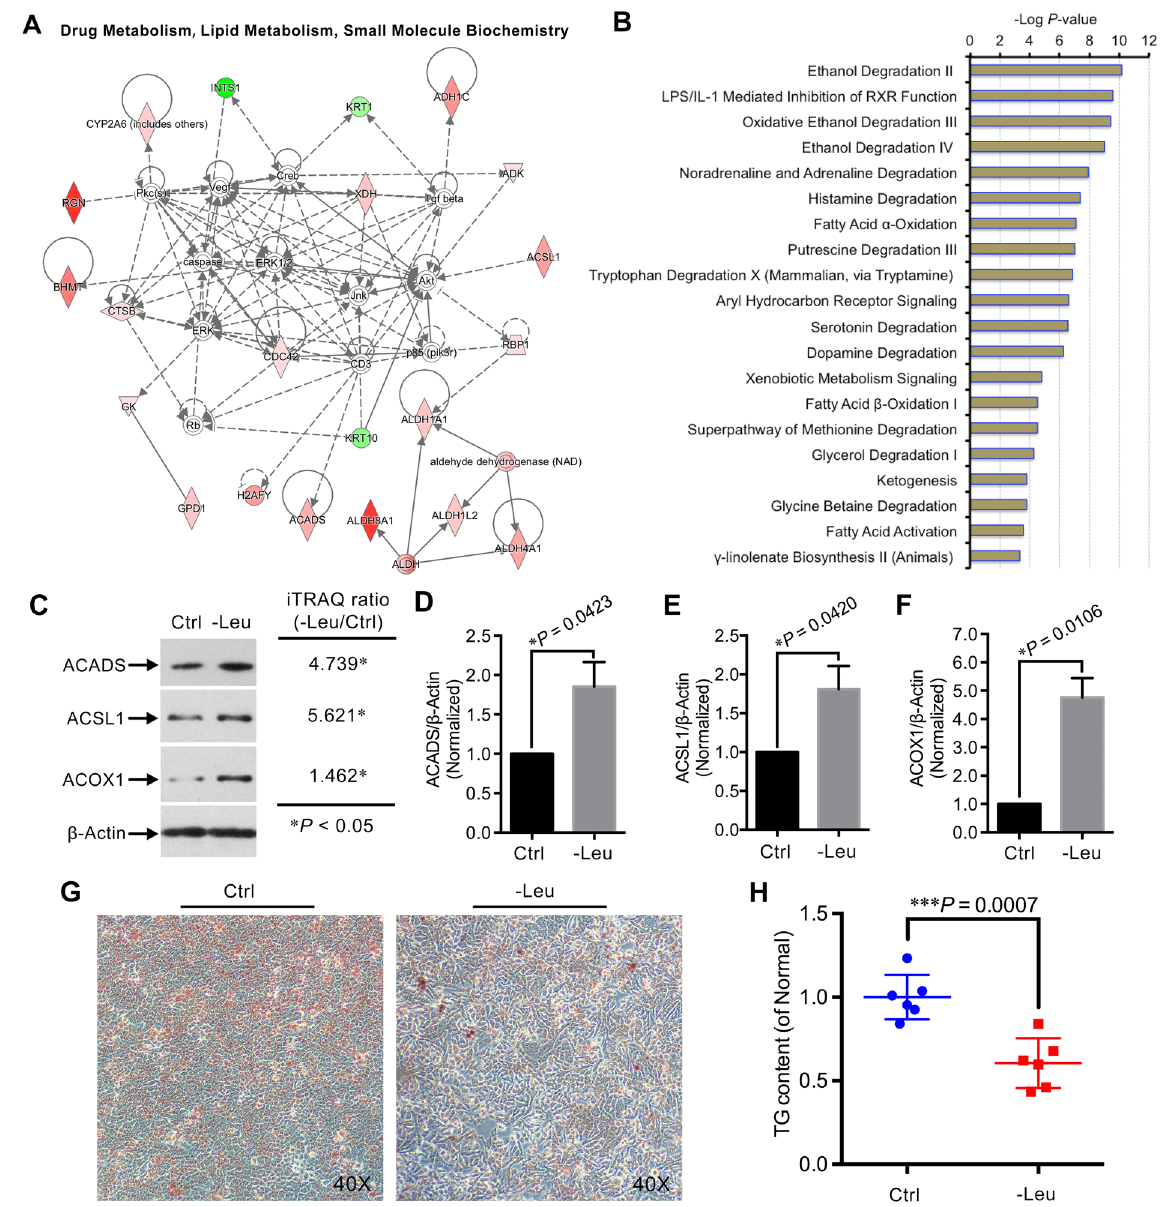
Figure 4. Leu deprivation activates the fatty acid β -oxidation pathway in HepG2 cells. ( A ) The most enriched interaction network of the differentially expressed proteins in Leu-deprived HepG2 cells. Red indicates up-regulated; green indicates down-regulated; white indicates proteins involved in certain network but not differentially expressed in this study. The degree of change for protein expression is indicated by color depth. ( B ) The 20 top canonical pathways ranked by the P -values in the IPA tools for the -Leu/Ctrl. ( C ) Immunoblotting of ACSL1, ACADS, ACOX1, and β -Actin in the HepG2 cells treated with Leu deprivation as indicated. ( D–F ) Quantitation of ACSL1/ β -Actin, ACADS/ β -Actin, and ACOX1/ β -Actin as described in ( C ). Data are means ± SD (n = 3). * P < 0.05 (paired Student’s t -test). ( G ) HepG2 cells were cultured with normal and Leu-deprived media for 24 hours, then cells were stained with ORO and observed with a microscope at 40x magnification. Representative images were shown. ( H ) Cellular TG content was measured in HepG2 cells with different treatments as described in ( G ). Data are means ± SD (n = 6). *** P < 0.001 (unpaired Student’s t